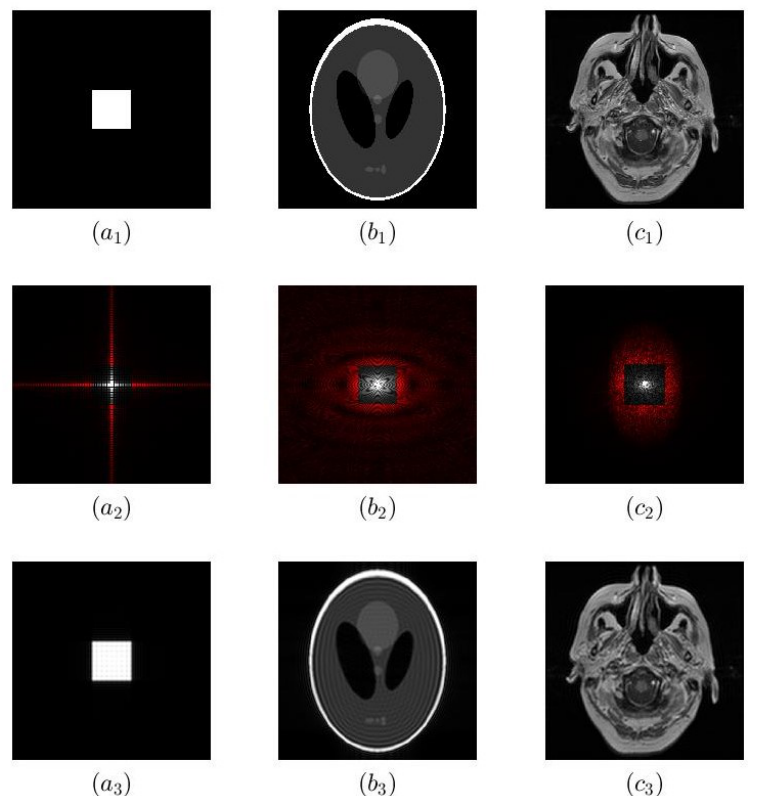
Figure 1. The three test images before and after introducing ringing. ( a 1 ) Original 400 × 400 numeri- cally simulated square. ( b 1 ) Original 400 × 400 Shepp–Logan phantom. ( c 1 ) Original 512 × 512 MR image. ( a 2 – c 2 ) Spectra of ( a 1 – c 1 ). Fourier coefficients highlighted in red are set to zero, simulating zero padding of a reduced number of measured Fourier coefficients. ( a 3 – c 3 ) Fourier reconstruction using ( a 2 – c 2 ) showing visible